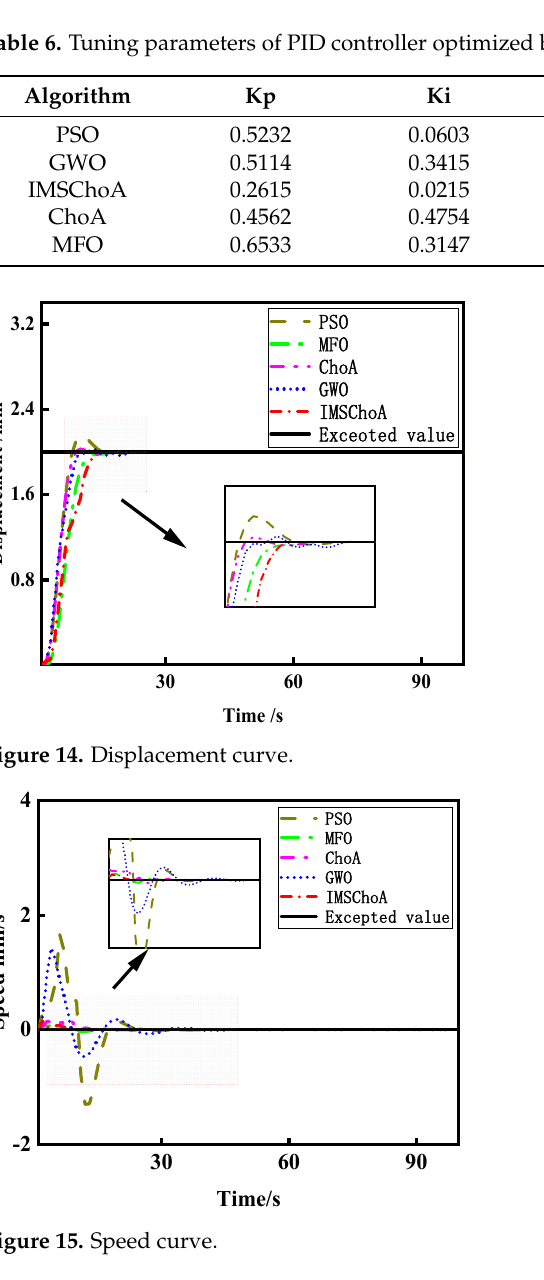
Table 6. Tuning parameters of PID controller optimized by different algorithms.